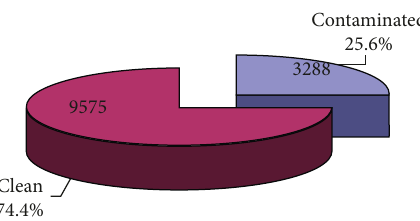
Figure 2: Percentage of contamination of the studied samples from different hospitals (2009–2015) in Assiut city.